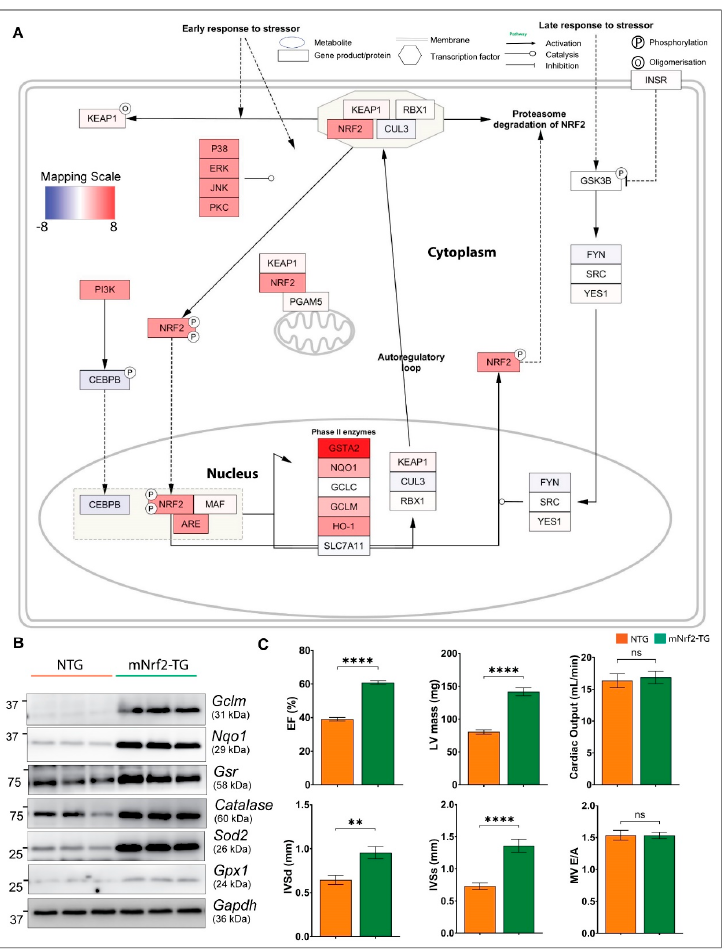
Figure 3. Gene expression mapped on the Nrf2 pathway (Wikipathways ID = 4357), cardiac structure and function. ( A ) Binding with Keap1/Cul3/RBX1 complex allows Nrf2 protein to be continually degraded via ubiquitination/proteosomal degradation. In response to ROS, Keap1 is oxidized or Nrf2 is phosphorylated resulting in translocation to nucleus. Pathway diagram shows changes in mNrf2-TG ARE targets when activated. Colour gradient scaled from blue (negative fold change) to red (positive fold change) was calculated using Log2foldchange, scaled and mapped onto curated network. Nodes (rectangle) represent genes or proteins and edges (or lines) represent interactions and relationships between connected nodes. ( B ) Validation of protein expression using Western blot, confirming the summary of changes in network. ( C ) Cardiac structure and function in mNrf2- TG mice. Two-dimensional non-invasive echocardiography (PSLAX axis) was used to determine systolic functions (i.e., ejection fraction and cardiac output), Left ventricle dimensions (i.e., LV mass, intraventricular septum diameter-systole and diastole) and diastolic function, i.e., mitral valve (early, E to late, A ratio) filling ( n =